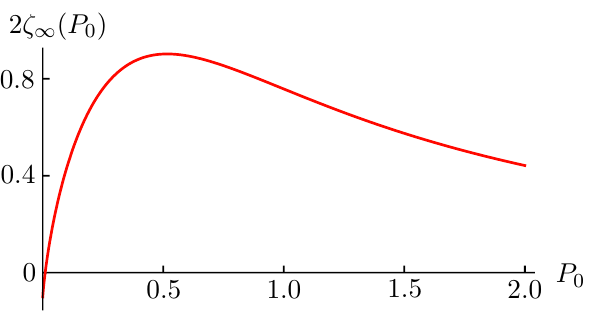
Figure 9 . Plot of the ‘height’ of the RT surface in cylindrical coordinates, as a function of the turning point P 0 characterising the surface. For (cid:16) 1 < (cid:16) crit at the same regions; otherwise there exists